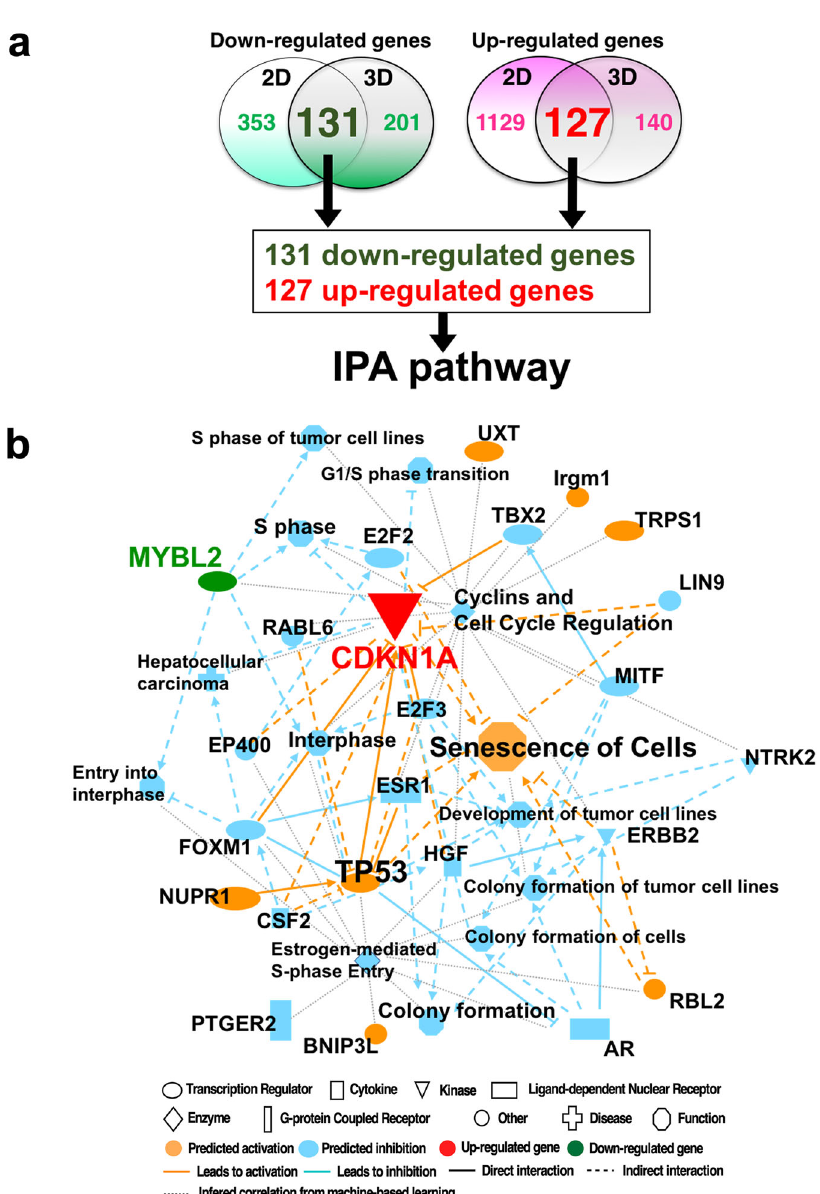
Fig. 3 Graphical summary and network analysis by IPA pathway using genes modulated by trehalose. a Venn diagram demonstrates the numbers of the downregulated genes and the upregulated genes analyzed in Fig. 2. There were 131 downregulated genes and 127 upregulated genes for an IPA. b A graphical summary shows the senescence cells, which are induced by p53 and CDKN1A, connected by the network analysis to the cellular